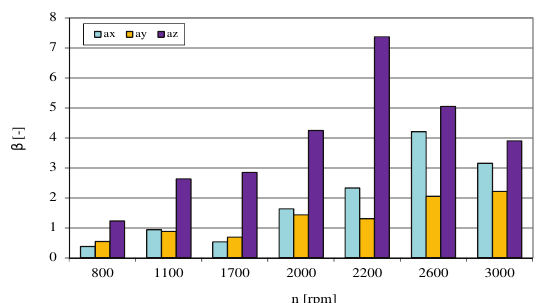
Fig. 11. Kurtosis of vibration accelerations for X, Y and Z dimensions and different engine speeds The obtained waveforms of the selected